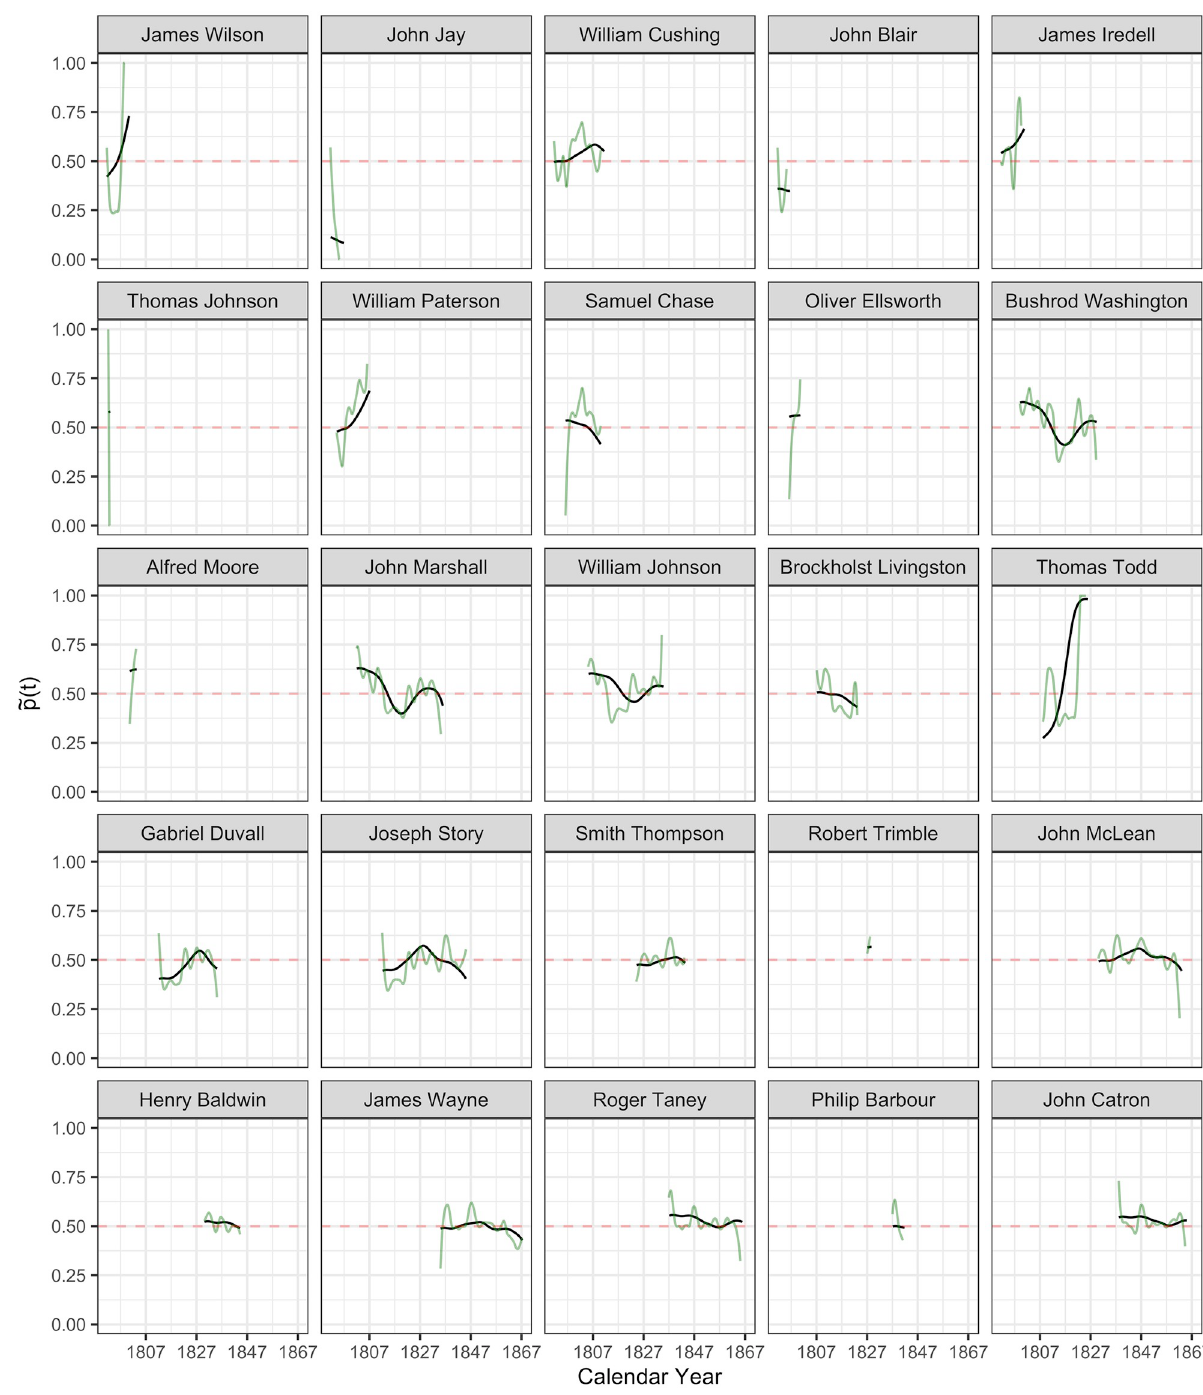
ð t Þ in probability scale, as per Eqs (7) and (8), from James Wilson to John Catron. Latent ideology i ð t Þ in green, where time t is calendar time. i